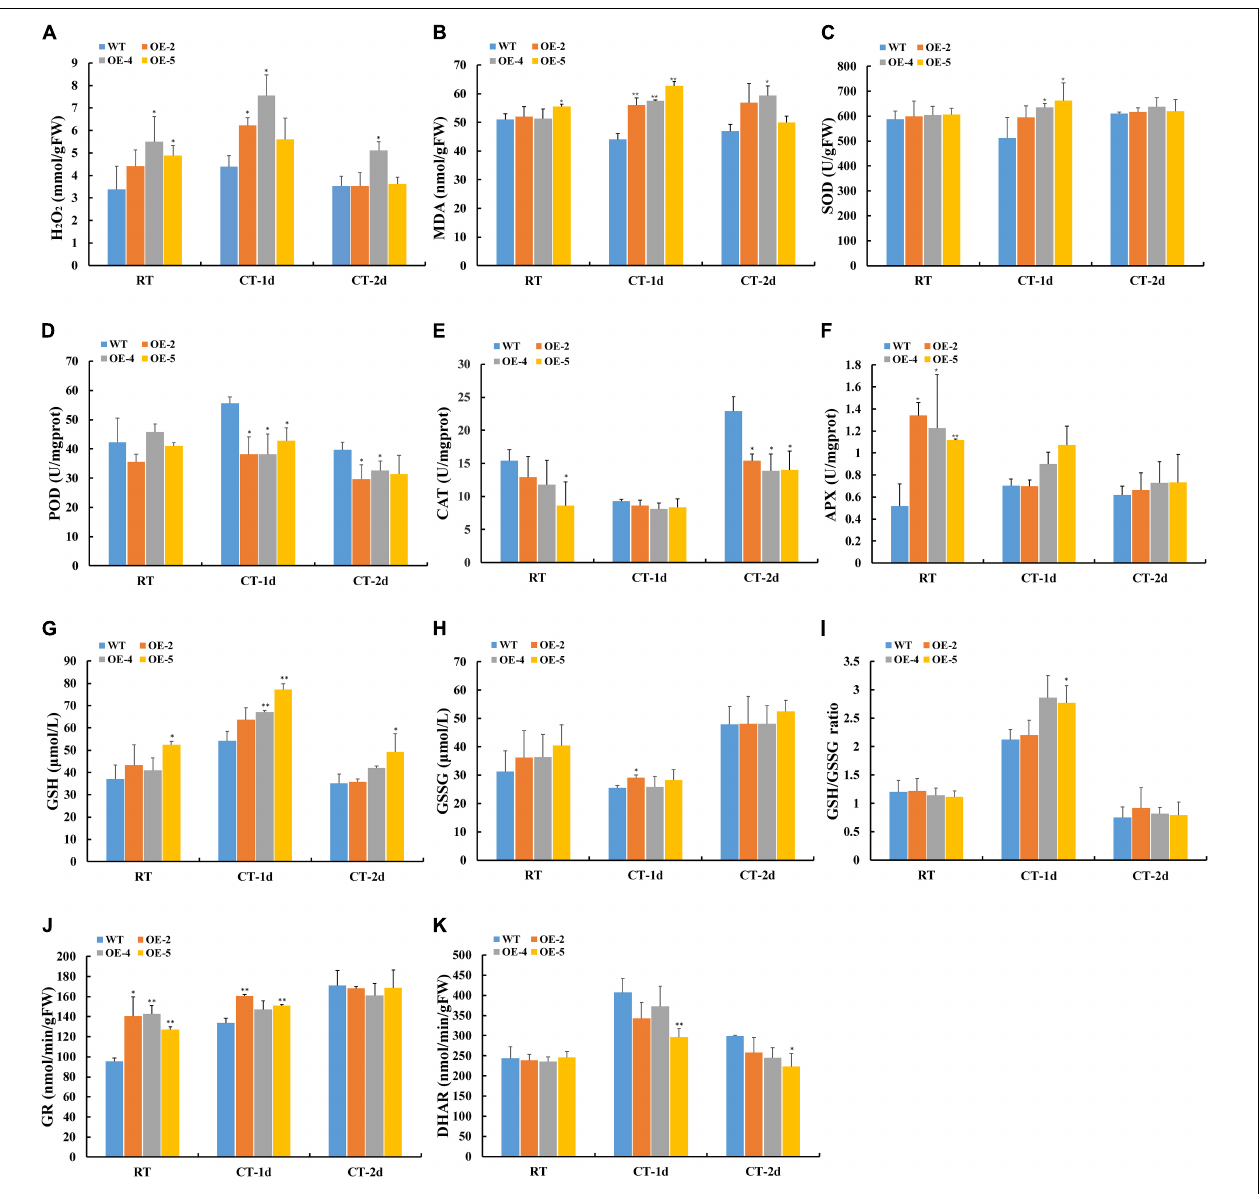
FIGURE 7 | Effect of RcGPX4 overexpression on metabolic content and the activities of antioxidant enzymes between WT and transgenic plants. (A) H 2 O 2 content; (B) MDA content; (C) SOD activity; (D) POD activity; (E) CAT activity; (F) APX activity; (G) reduced GSH content; (H) GSSG content; (I) GSH/GSSG ratio; (J) GR activity; and (K) DHAR activity. RT: room temperature (22 ◦ C); CT-1: cold temperature (4 ◦ C) for 1 day; CT-2: cold temperature (4 ◦ C) for 2 days. FW: fresh weight. Data represent the mean ± SD of three independent biological replicates. Asterisks indicate a significant difference between wild type and overexpressed lines ( ∗ P < 0.05, ∗∗ P < 0.01, student’s t -test). WT, wild type; H 2 O 2 , hydrogen peroxide; MDA, malondialdehyde; SOD, superoxide dismutase; CAT, catalase; POD, peroxidase; GSSG, oxidized GSH; APX, activities of L-ascorbate peroxidase; GSH, glutathione; GR, glutathione reductase; DHAR, dehydroascorbate